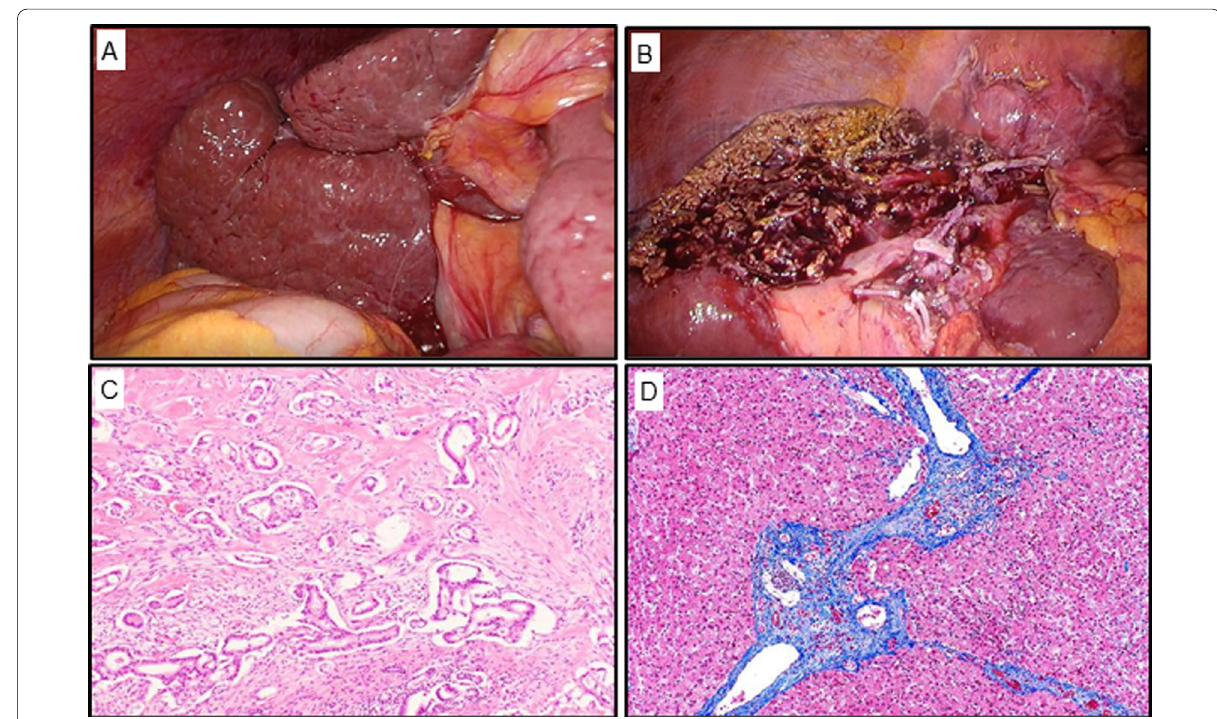
Fig. 3 Intraoperative findings during operation. The cirrhosis change was found in surface of right lobe ( A ), laparoscopic left hemihepatectomy was performed ( B ). Pathological examination moderately differentiated ( C ). Masson’s Trichrome stain shows the liver fibrosis in the background liver ( D